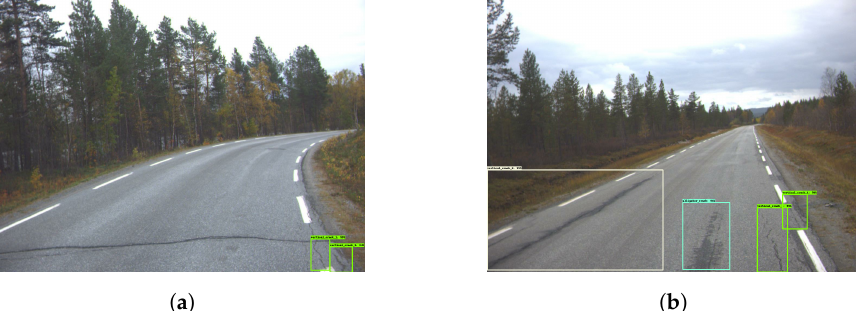
Figure 16. Missed damage detection—Model 4. The green and yellow boxes represent the vertical cracks while cyan colored boxes are the horizontal cracks.